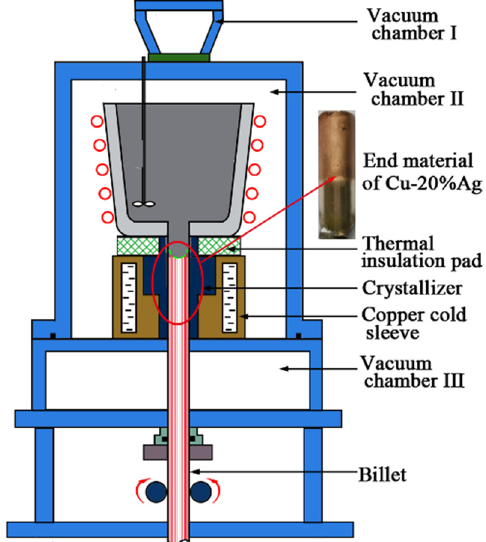
Figure 1: Schematic diagram of cold - type vertical continuous casting Cu – 20% Ag rod